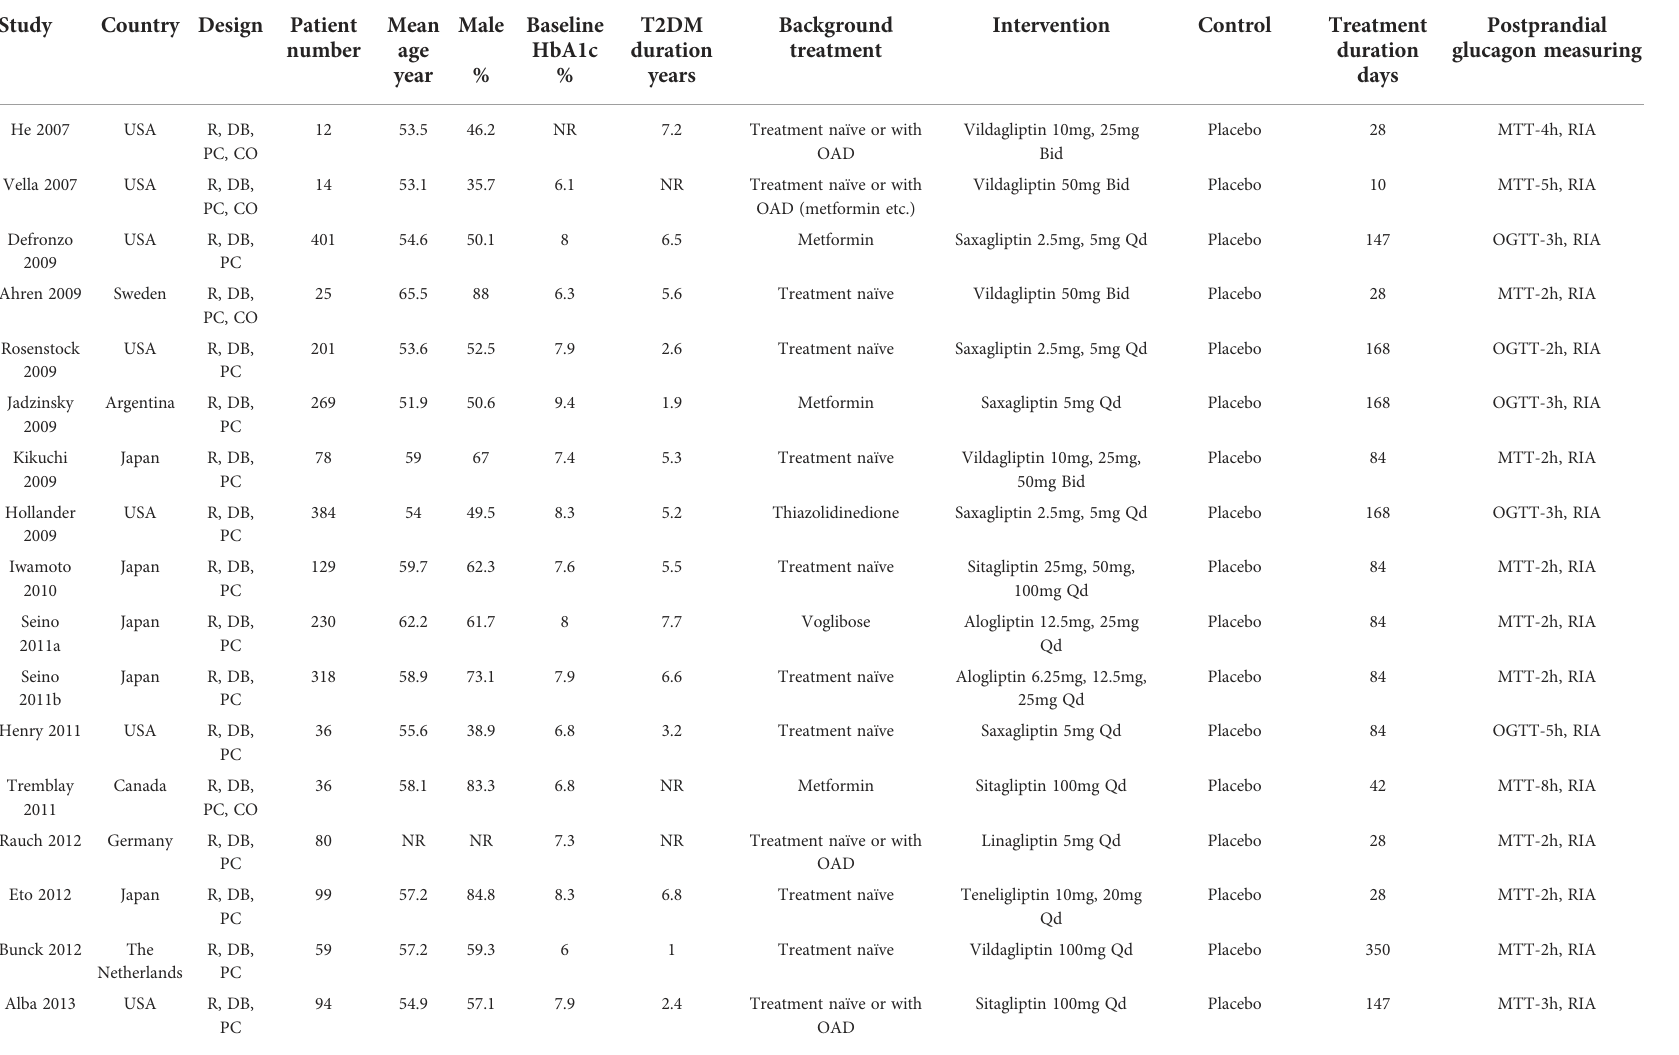
TABLE 1 Characteristics of the included studies. Comparisons between DPP4 inhibitors and placebo